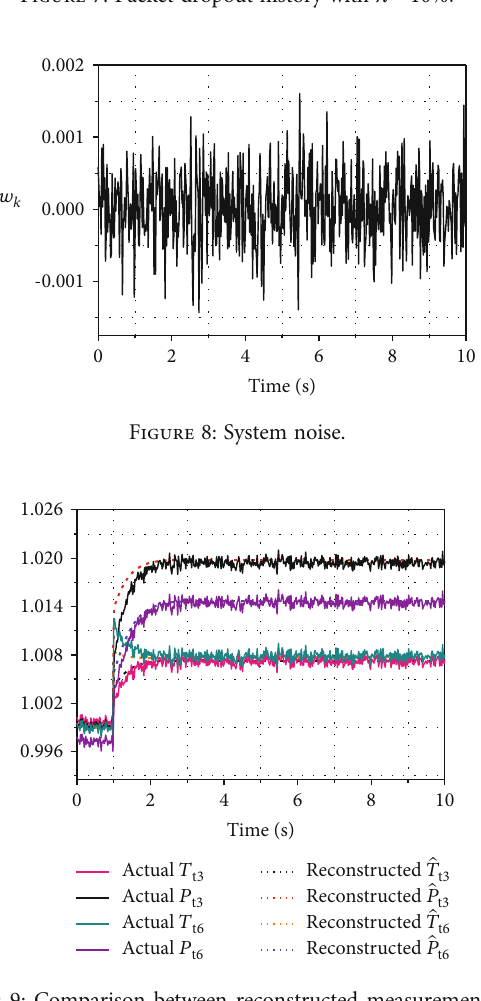
Figure 7: Packet dropout history with λ = 10 % :